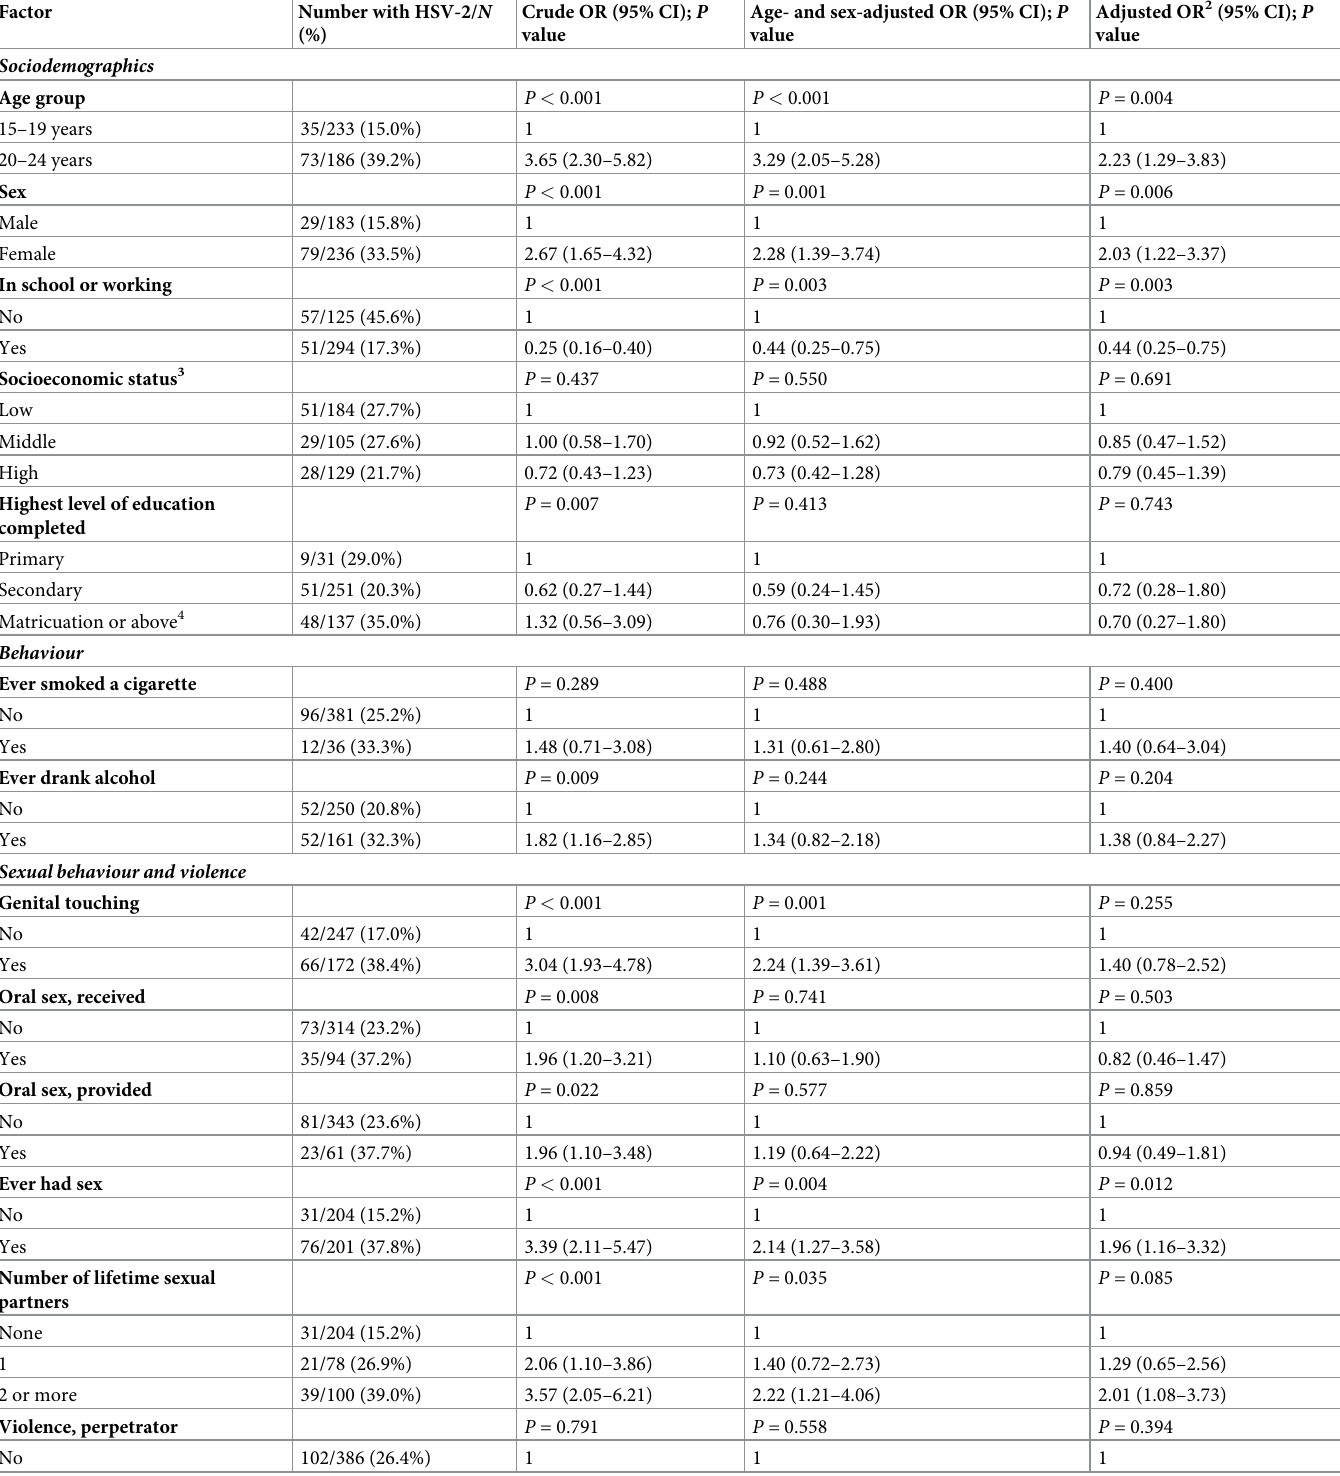
Table 4. Factors associated with HSV-2 in a population-based sexually transmitted infection survey among young people aged 15–24 years in rural Kwa-Zulu Natal ( N = 419 1 ).